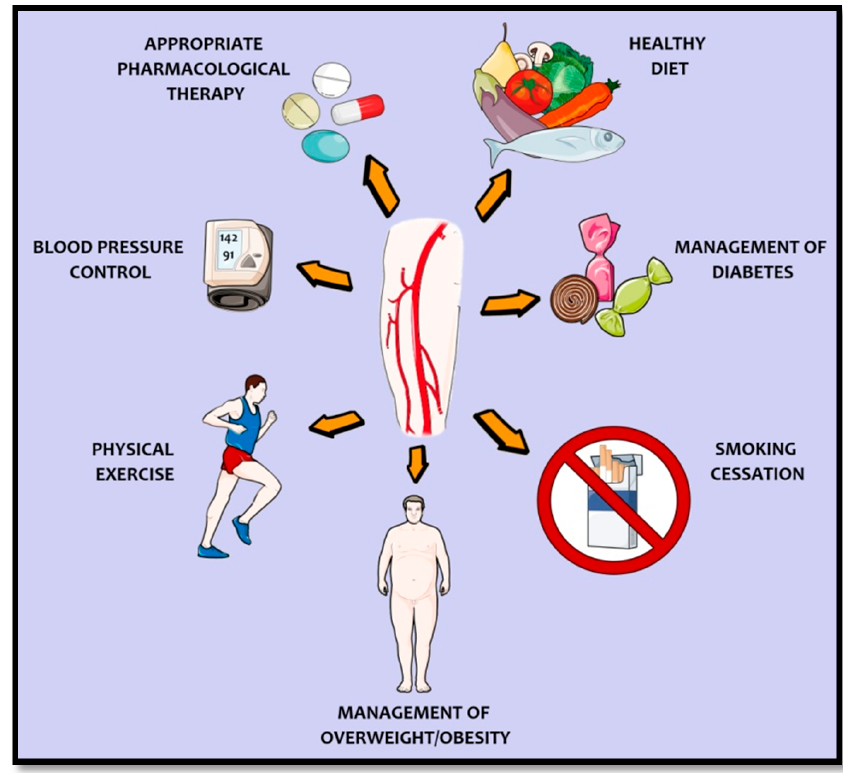
Figure 2. Integrated and multidisciplinary management of peripheral artery disease.